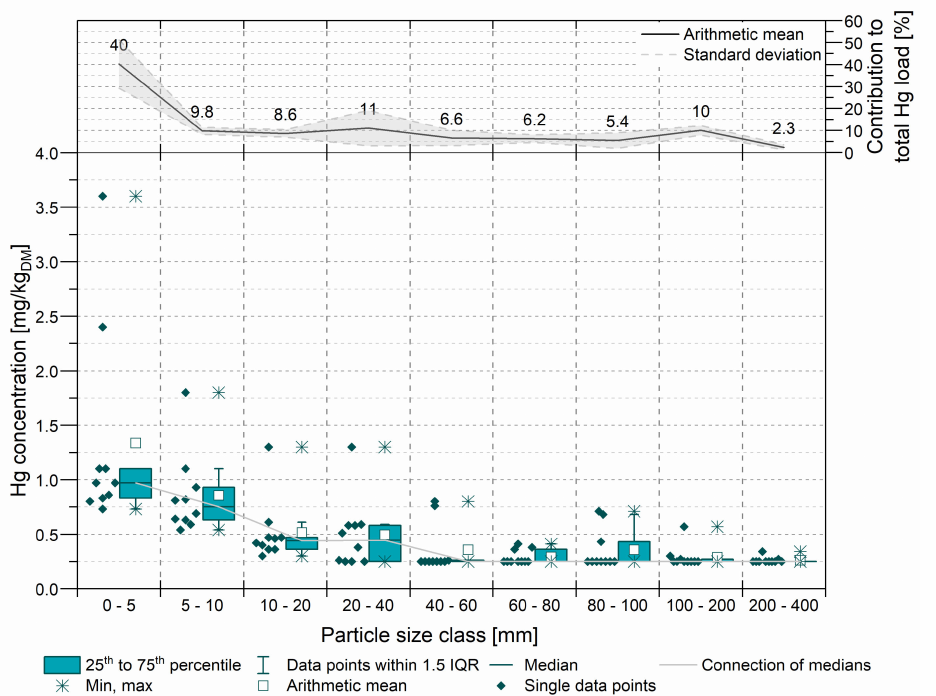
Figure 6. Concentrations of Hg in different particle size classes of mixed commercial waste and contribution of each particle size fraction to the total Hg load [37].